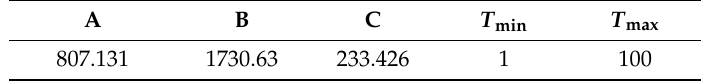
Table 1. Parameter for the Antoine equation with T [ ◦ C] and p sat [mm Hg] [15]. A B C T min T max 807.131 1730.63 233.426 1